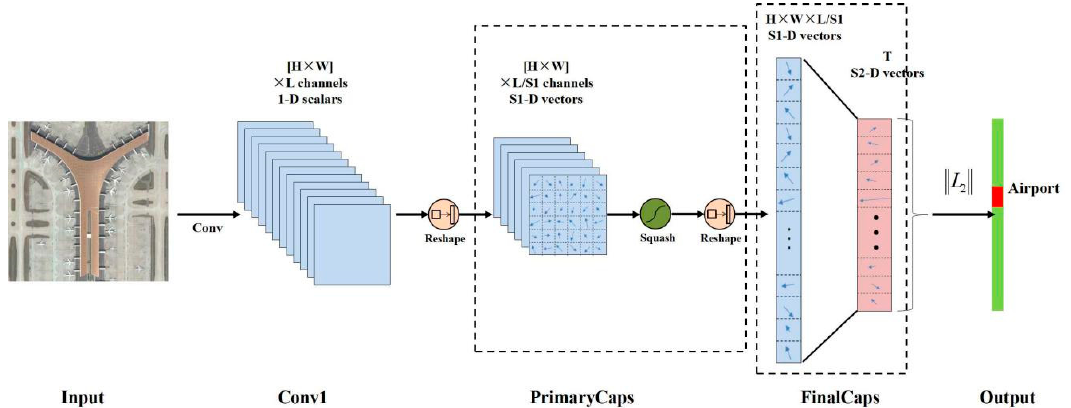
Figure 7. A typical CapsNet architecture. Remote Sens. 2018 , 10 , x FOR PEER REVIEW